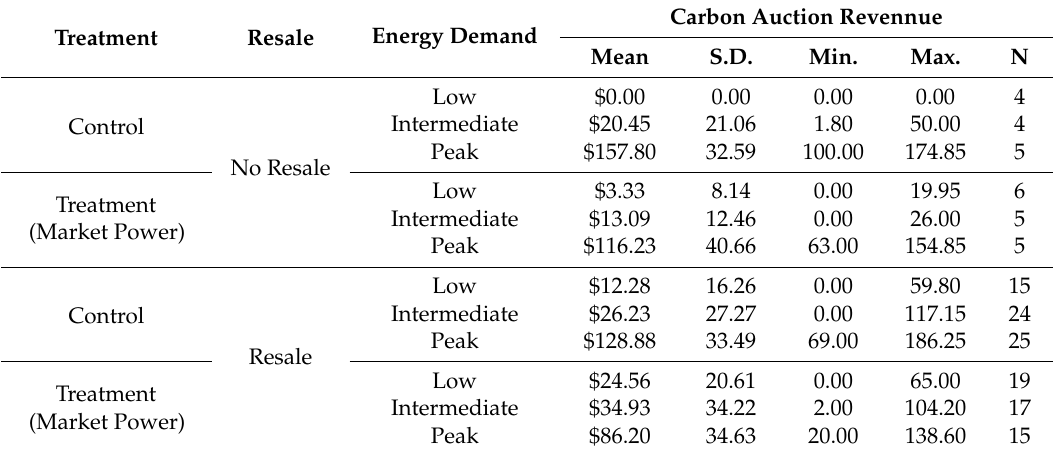
Table 2. Descriptive statistics (decomposed by